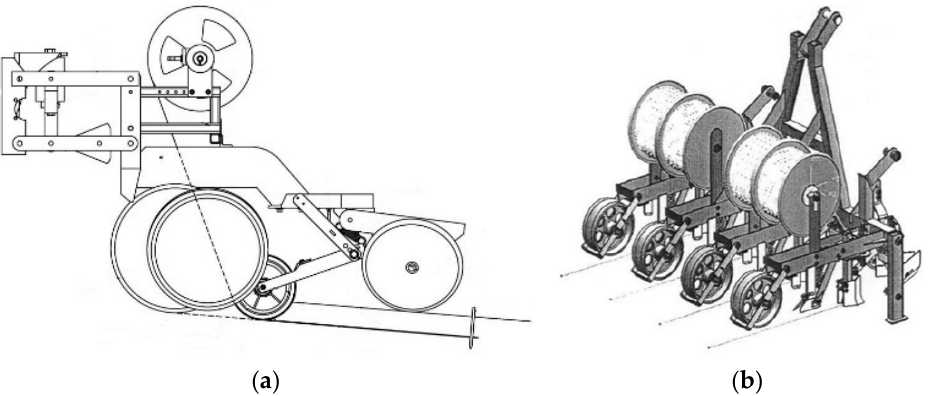
Figure 10. Two kinds of hand-guided types of tape planter. ( a ) Seed tape planter designed by Deppermann (https://patentimages.storage.googleapis.com/71/f7/53/666419465f4e7e/US20130152836A1.pdf (accessed on 20 November 2021)) [93]; ( b ) Seed tape planter designed by Lv [95].